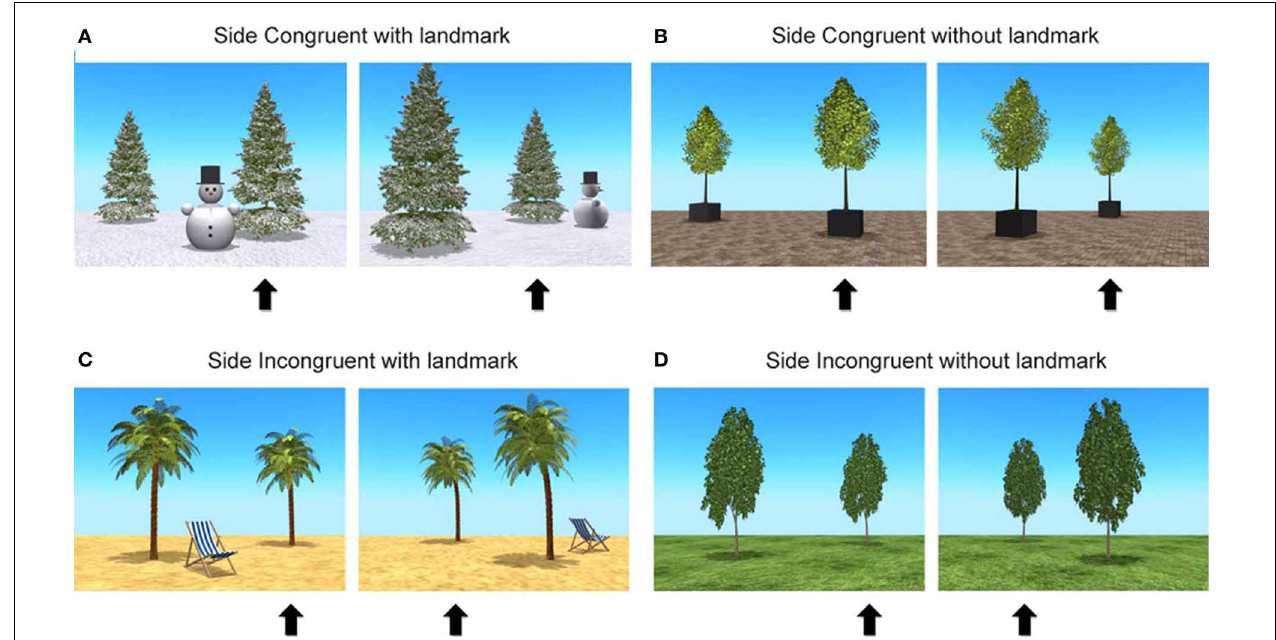
The figure shows (A) a SCon trial with landmark, and (B) a SCon trial without landmark, where the position of the hiding tree which was right before rotation remained the right tree after 90 ◦ rotation to the left, (C) a SInc trial with landmark, and (D) a SInc trial without landmark, where the position of the hiding tree, which was right before rotation, becomes the left tree after 90 ◦ rotation to the